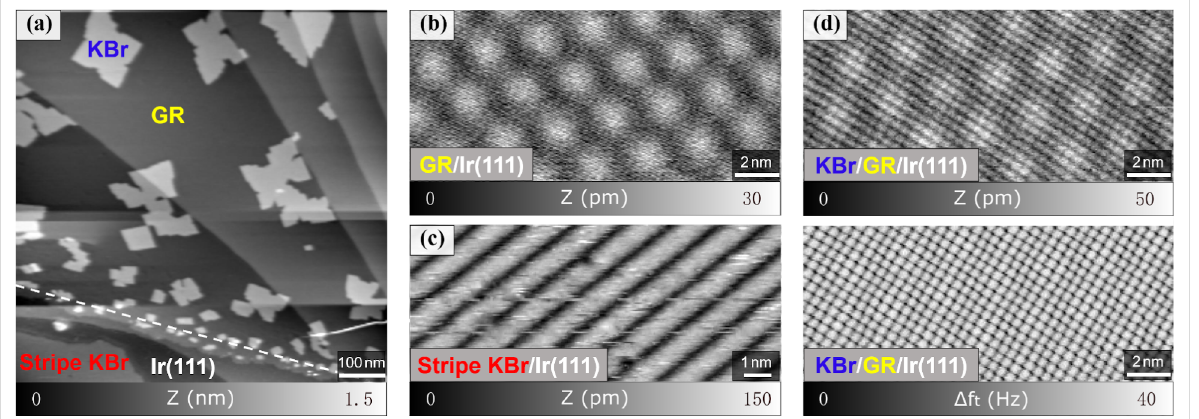
Figure 4: Cubic KBr on the GR/Ir(111) surface. (a) Two different KBr structures have been discovered on GR/Ir(111) and bare Ir(111). (b) Single moiré pattern of GR/Ir(111) ( A 1 = 2 nm, Δ f 1 = − 85 Hz, γ = − 70 pN·nm 1/2 ). (c) Corrugated KBr on bare Ir(111) with the stripe structure ( A 1 = 2 nm, Δ f 1 = − 50 Hz, γ = − 41 pN·nm 1/2 ). (d) Multiple moiré pattern of GR/Ir(111) ( A 1 = 2 nm, Δ f 1 = − 300 Hz, γ = − 247 pN·nm 1/2 ), with the torsional frequency shift Δ f t image below ( A t = 30